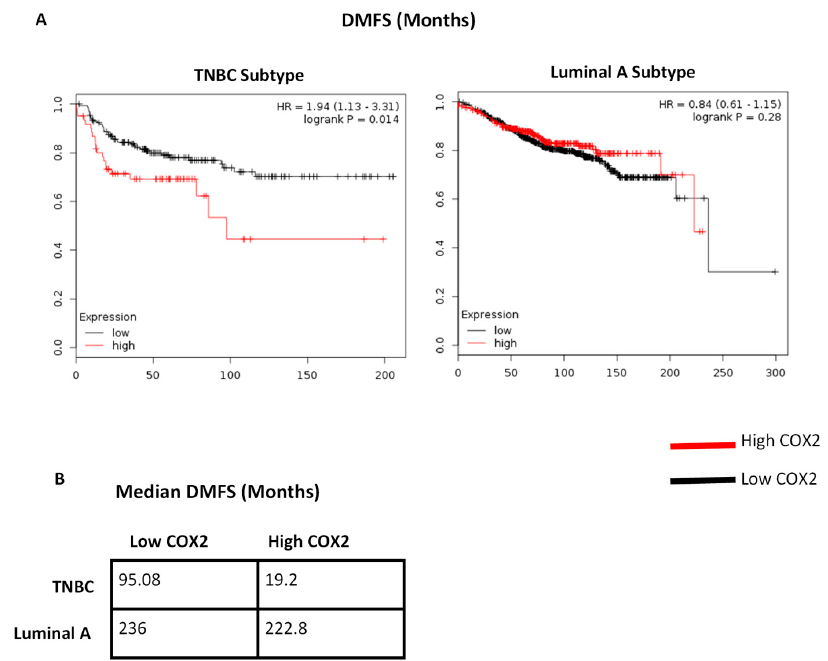
Figure 5. COX2 expression has prognostic significance in basal, but not Luminal A intrinsic breast carcinoma subtypes. ( A ) Interrogation of public microarray repositories using KMPLOT online analysis tool (KMPLOT.COM), DMFS was compared between those with high COX2 expression to those with low COX2 expression, in patients with either basal or luminal breast cancer subtypes. The median time of DMFS in the same cohort is summarized in ( B ).